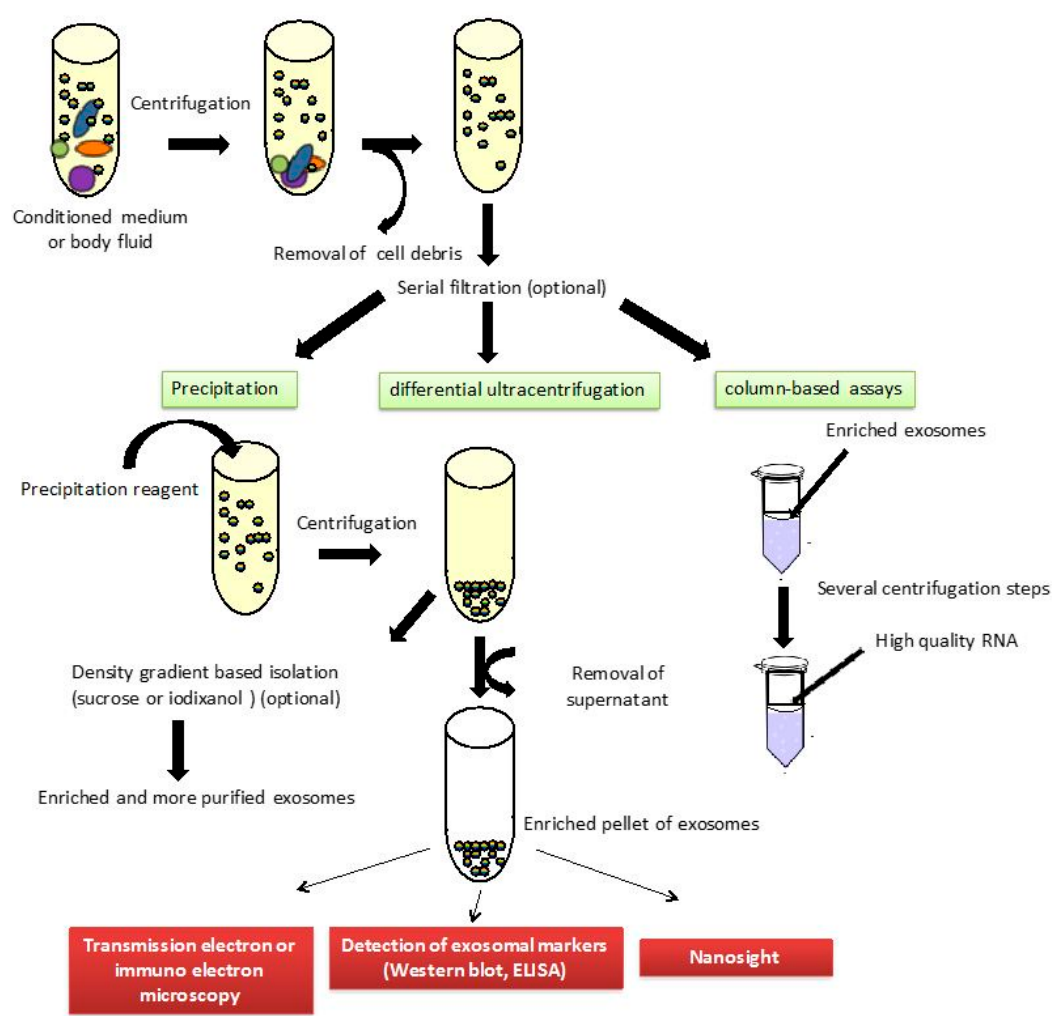
Figure 6. Exosome isolation procedures. The different size particles contained in body fluids or conditioned media are drawn as different color circles.